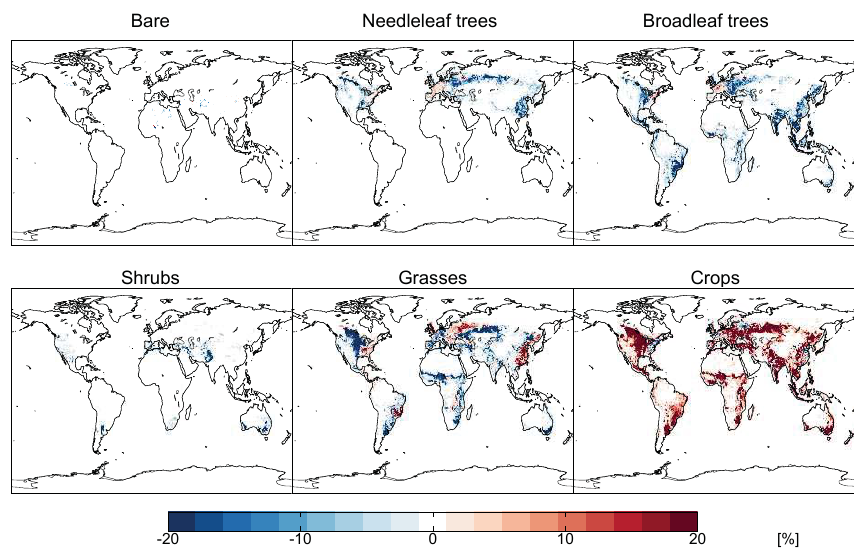
Figure 2. Change from preindustrial (1850) to present day (2000) in the percentage of land area occupied by six classes of